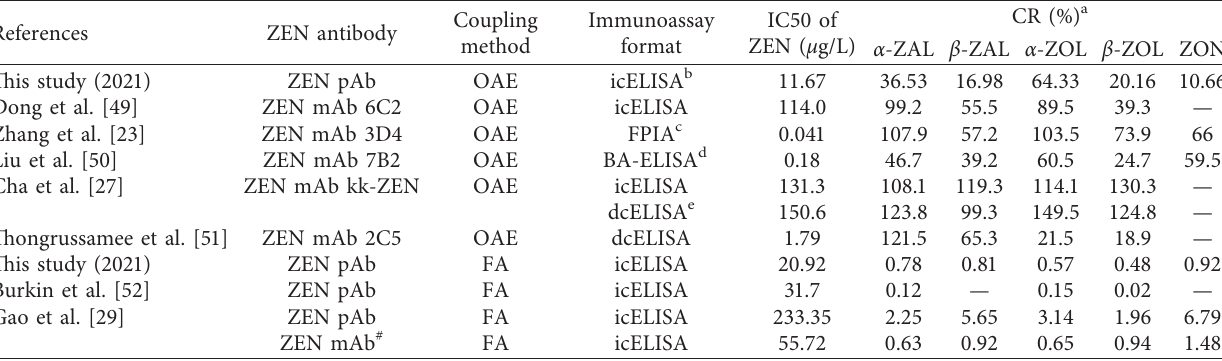
Table 4: Comparison of IC50 values and CR values of ZEN pAbs by the OAE method and FA method in this study and other previously reported ZEN pAbs and ZEN mAbs.